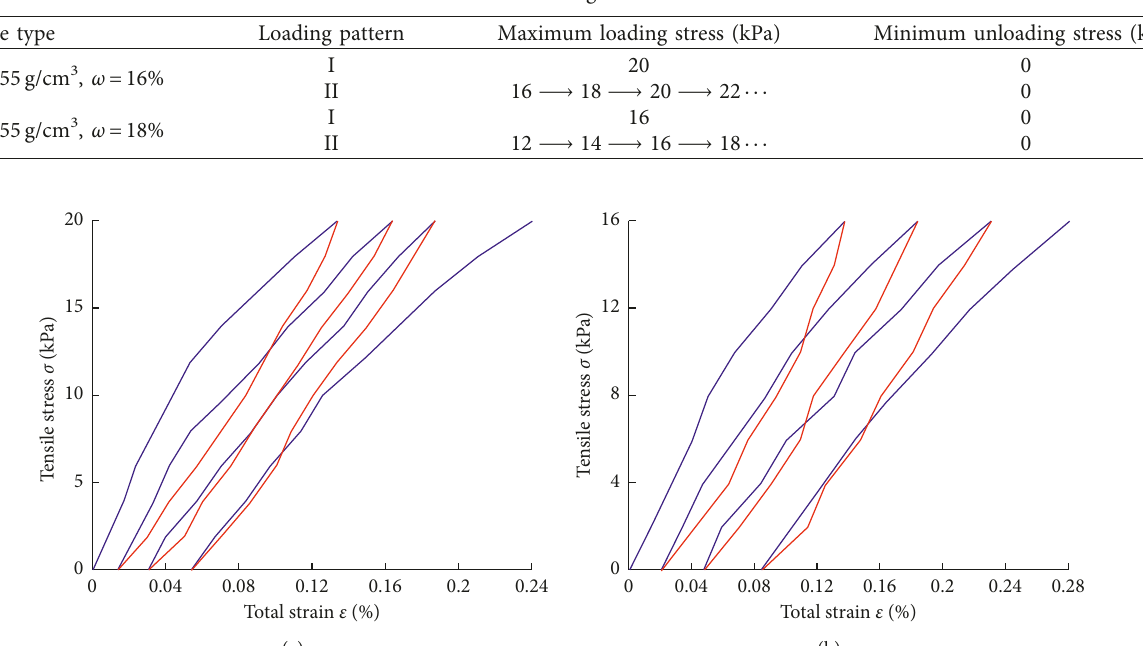
� 1.55g/cm 3 and (b) ρ d